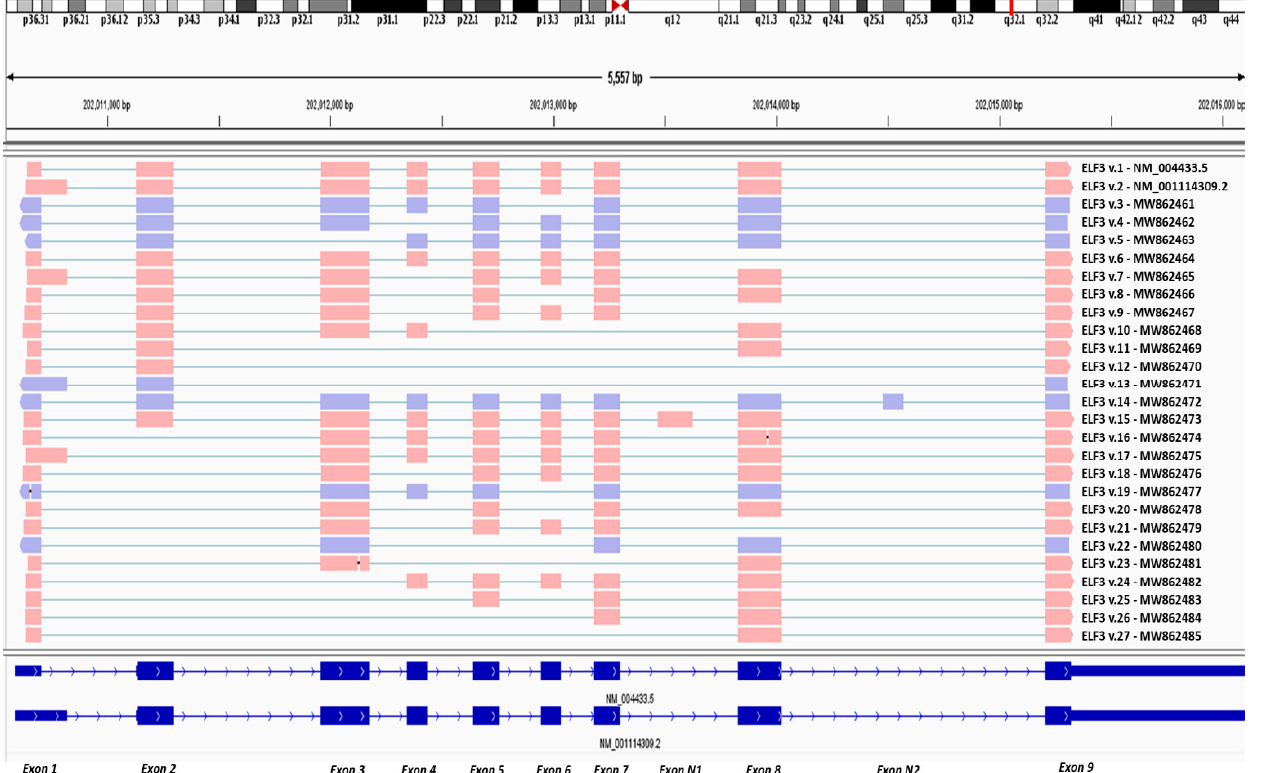
Figure 1. Visualization of the aligned sequencing reads representing novel alternative splice variants of the human ELF3 gene, using Integrative Genomics Viewer (IGV).